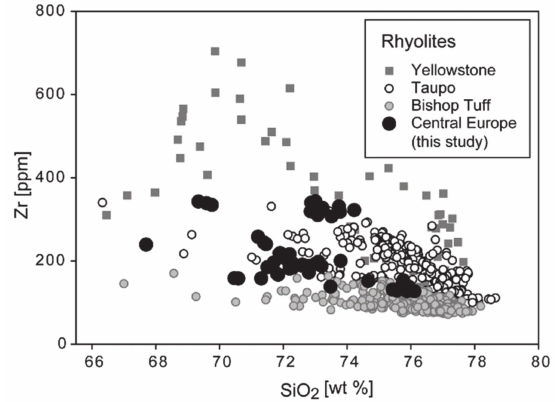
Figure 9. Comparison of whole rock SiO 2 and Zr contents in the studied rhyolites (including the whole rock composition published in [9,15] with datasets from Bishop Tu ff [35], Taupo Volcanic Zone [43], and Yellowstone